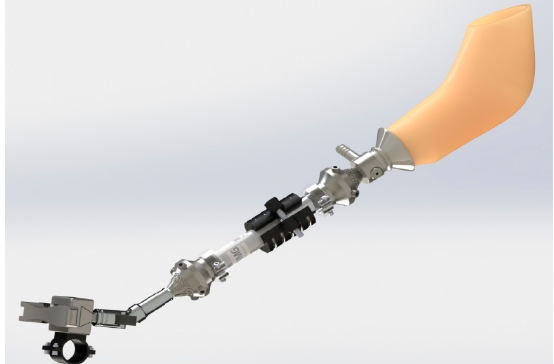
Figure 6. Final prosthesis design (assembled view).